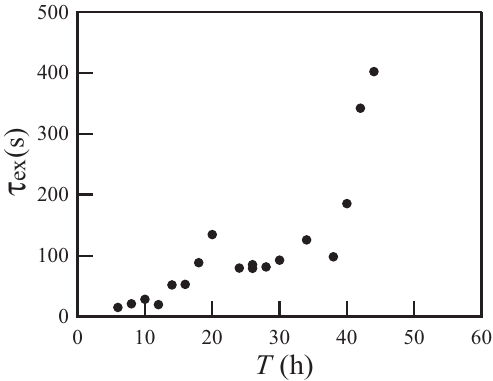
Figure 4. Relationship between T and τ ex , where τ ex is the time elapsed between the application of the organic solvent and the appearance of bumps of 0.2 mm